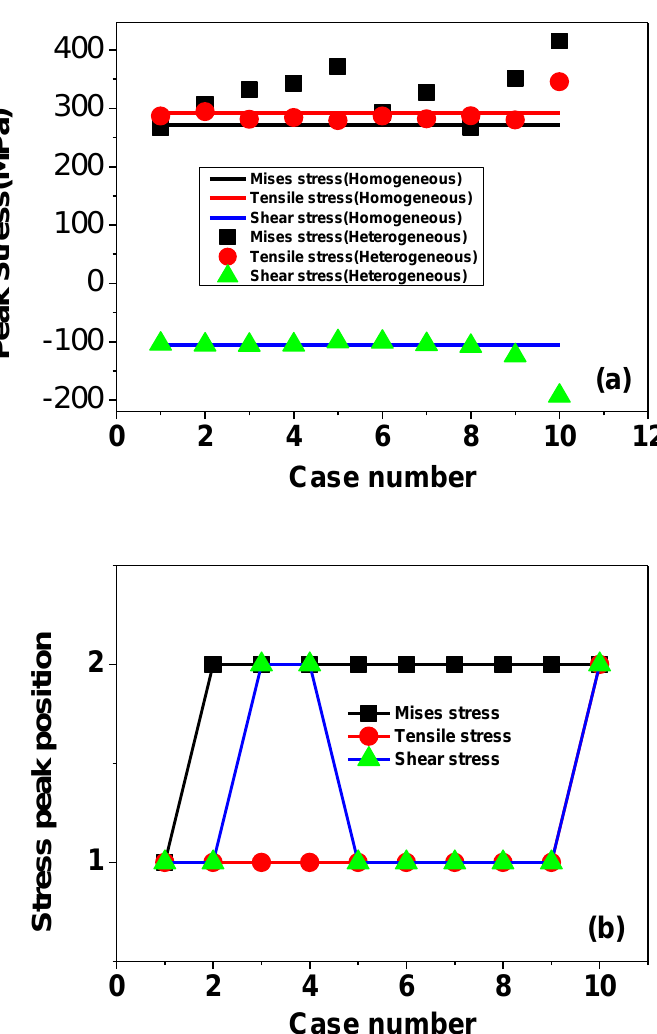
Figure 13. ( a ) Comparison of stress peaks between heterogeneous materials and homogenous materials, and ( b ) their location of all cases.